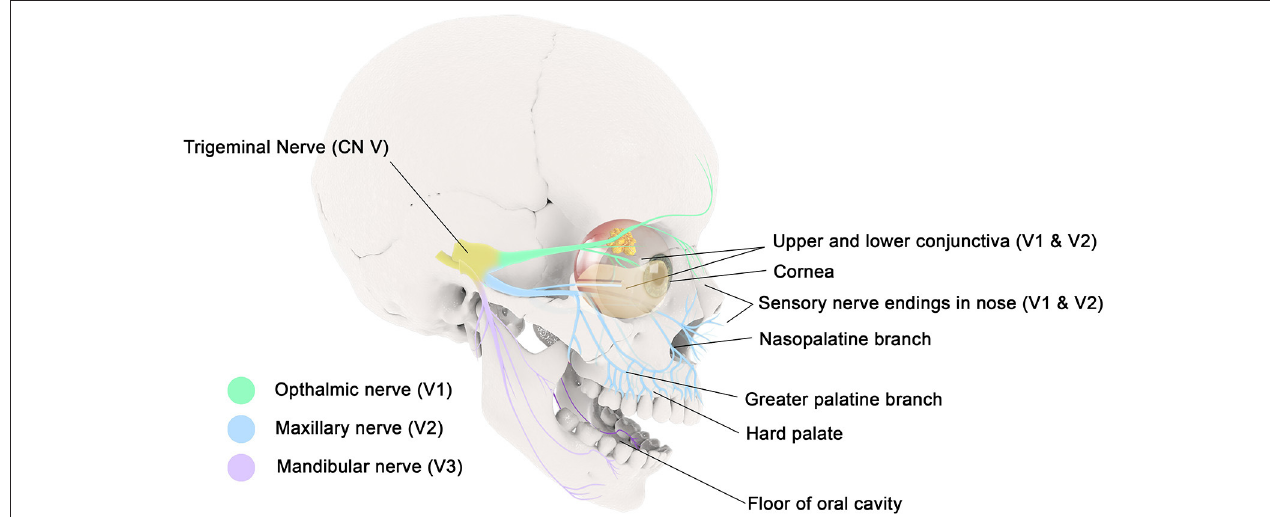
FIGURE 1 | The ophthalmic nerve (V1) innervates the mucous membranes of the frontal and ethmoidal sinus, upper eyelid and its conjunctiva, and cornea. The maxillary nerve (V2) innervates the mucous membranes of the lower eyelid and its conjunctiva, maxillary sinus, nasal cavity, upper lip, upper gingiva, and hard palate. The mandibular nerve (V3) innervates the mucous membranes of the floor of the oral cavity, the lower lip, anterior two-thirds of the tongue, and lower gingiva.